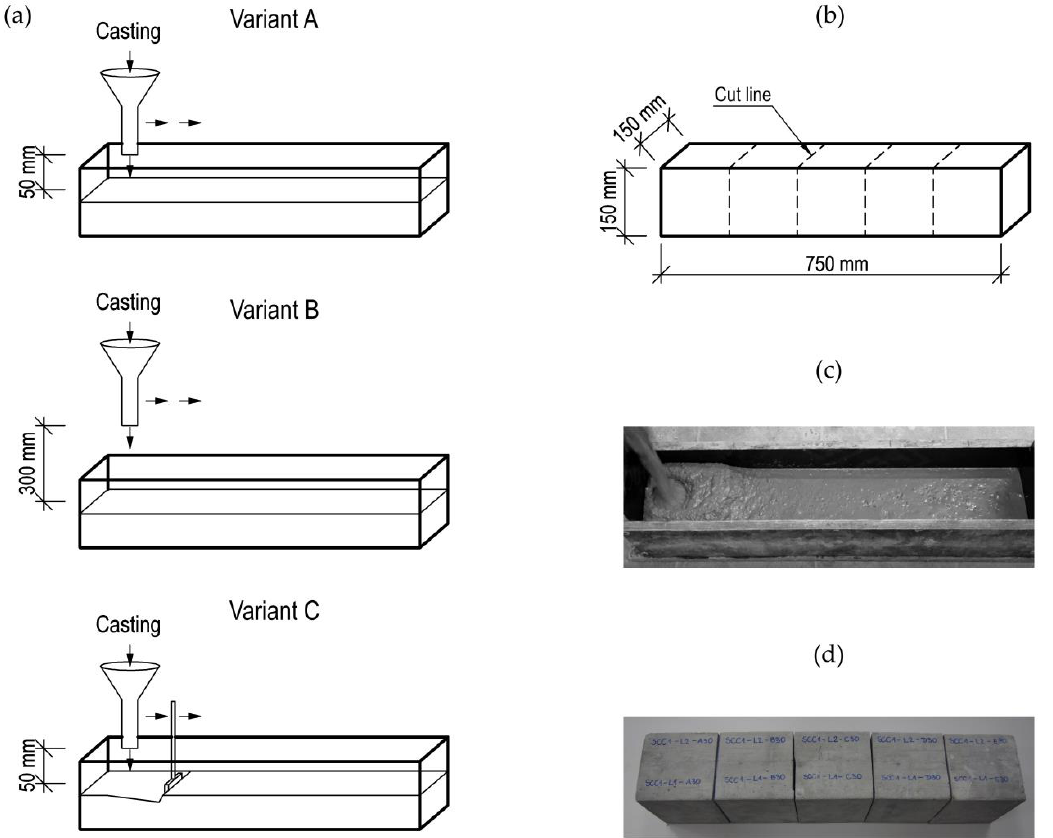
Figure 1. The test elements used in the studies: ( a ) A schematic view of multilayer casting variants; ( b ) a schematic view of a test element; ( c ) a variant of multilayer casting of an increased drop height; ( d ) a test element cut into modules.